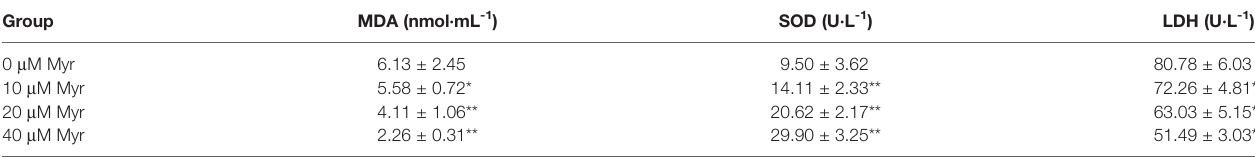
TABLE 1 | Effects of different concentrations of Myr on MDA, SOD and LDH in SKOV3 cells.